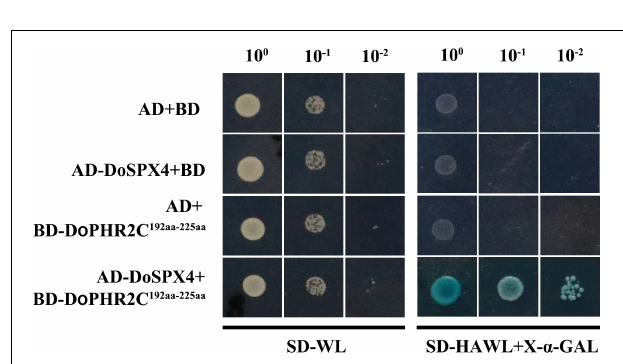
FIGURE 5 | Subcellular localization of DoSPX4 protein in Nicotiana tabacum epidermal cells. The results were observed by confocal laser microscopy. The pictures show a green fluorescent field, a bright field and an overlay of two fields (merge). The numerical reading of the red ruler is 20 µ m.